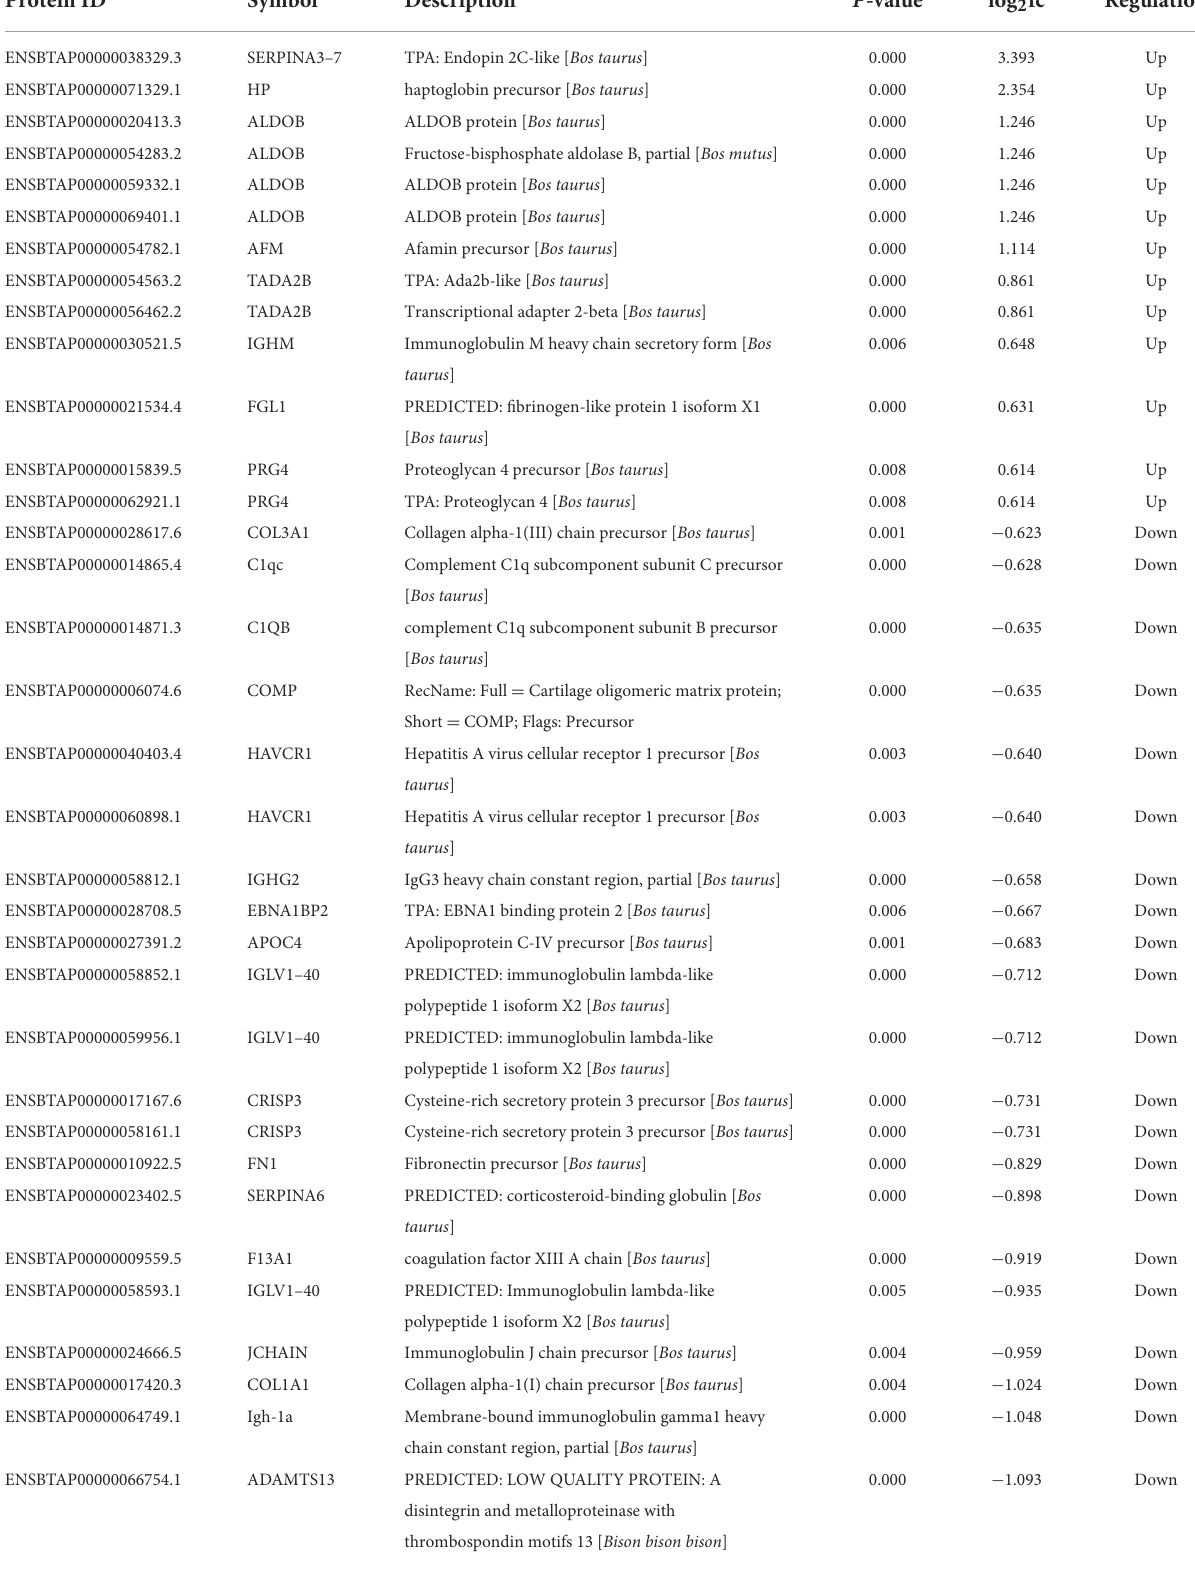
TABLE 4 List of significantly regulated proteins in plasm of DHD calves vs. healthy caves. Protein